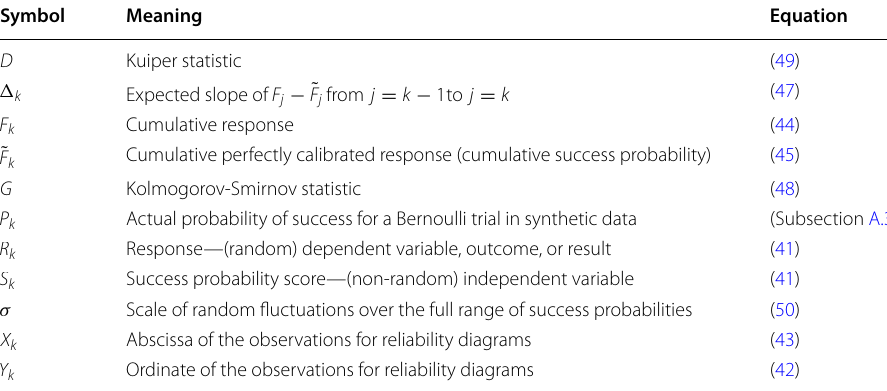
Table 1 summarizes the notation used before the appendices. The symbols in the tables are in alphabetical